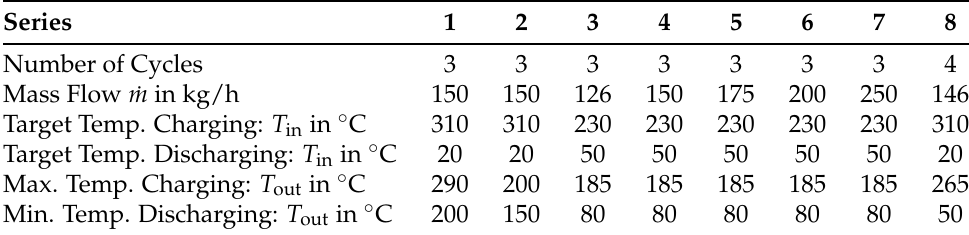
Table 1. Measurement series of the